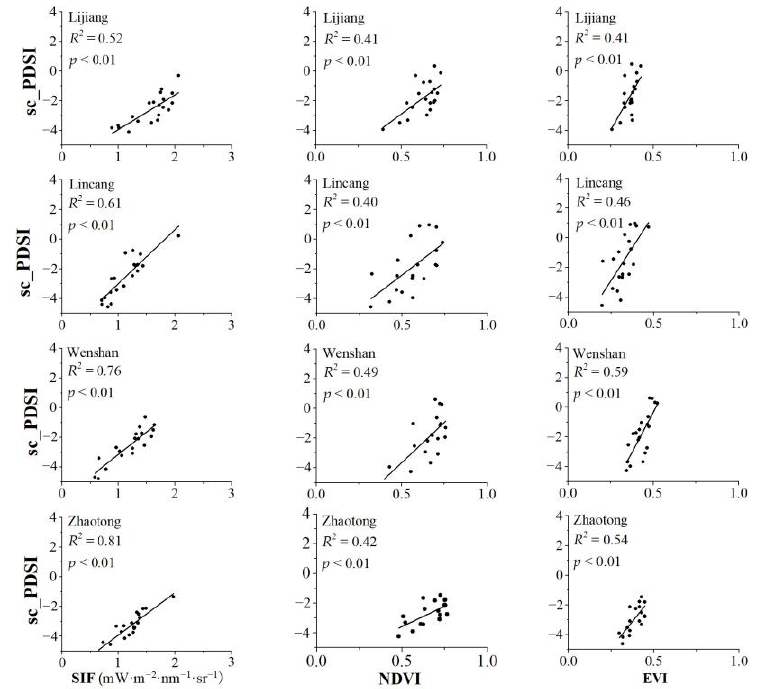
Figure 5. Scatter chart of SIF, NDVI, and EVI with sc_PDSI at the Yunnan